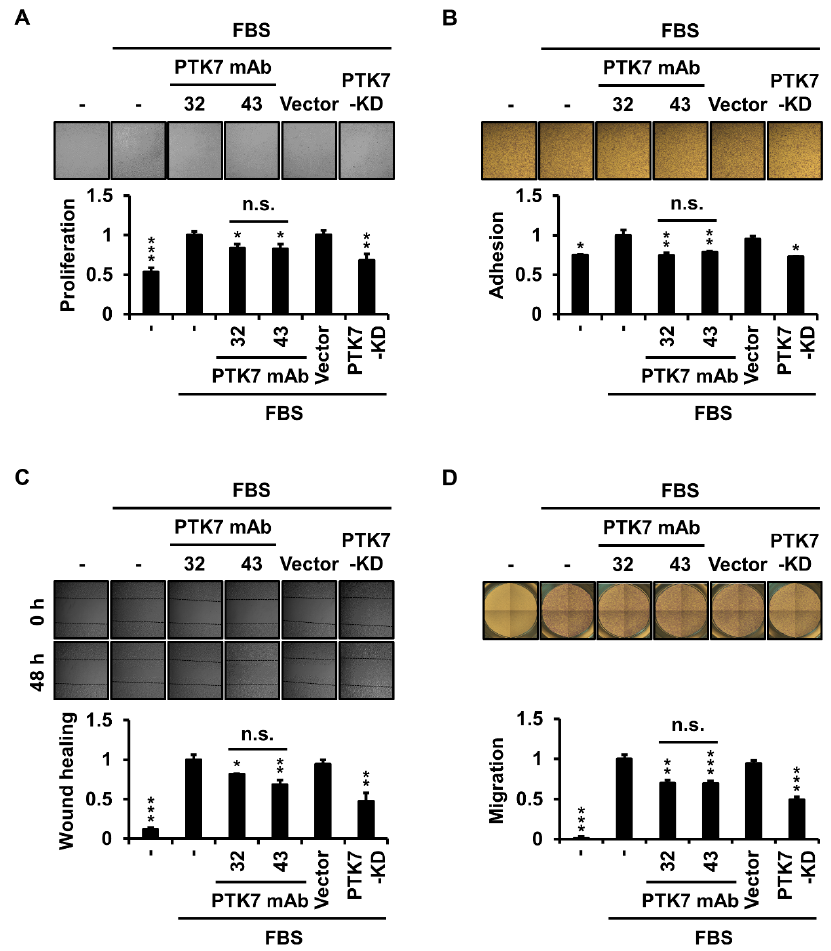
Figure 2. PTK7 mAbs reduce 3D cell proliferation, adhesion, wound healing, and migration in KYSE-30 cells. KYSE-30 cells were incubated in Dulbecco’s modified Eagle medium/nutrient mix- ture F-12 (DMEM/F12) medium with or without 2% fetal bovine serum (FBS) in the presence of PTK7 mAb (10 μg/mL) for the indicated time intervals. KYSE-30 cells infected with the vector or PTK7 knockdown viruses were used as controls. ( A ) Cell proliferation was analyzed after incuba- tion for 72 h in a 3D culture system in which the cells were embedded in Matrigel. Viable cells were measured using the WST-8 assay. Representative micrograph images (×100) taken at 72 h after plat- ing are shown. ( B ) Cell adhesion was analyzed 1 h after plating in a 96-well plate pre-coated with type I collagen. The adherent cells were stained with crystal violet. Representative micrographs (×100) are shown. ( C ) Wound healing was analyzed 48 h after wounding in a monolayer of cells. Representative micrograph images (×100) taken at 0 and 48 h after wounding are shown. ( D ) Chem- otactic migration was analyzed after incubation for 24 h in a Transwell plate. The migrated cells were stained with crystal violet. Representative micrographs (×40) are shown. The quantitation of each assay is described in the Materials and Methods section. Each bar represents the mean ± SD of three independent experiments: * p < 0.05, ** p < 0.01, or *** p < 0.001 vs. cells treated with FBS alone; n.s. (not significant) between PTK7 mAb-32 and PTK7 mAb-43.